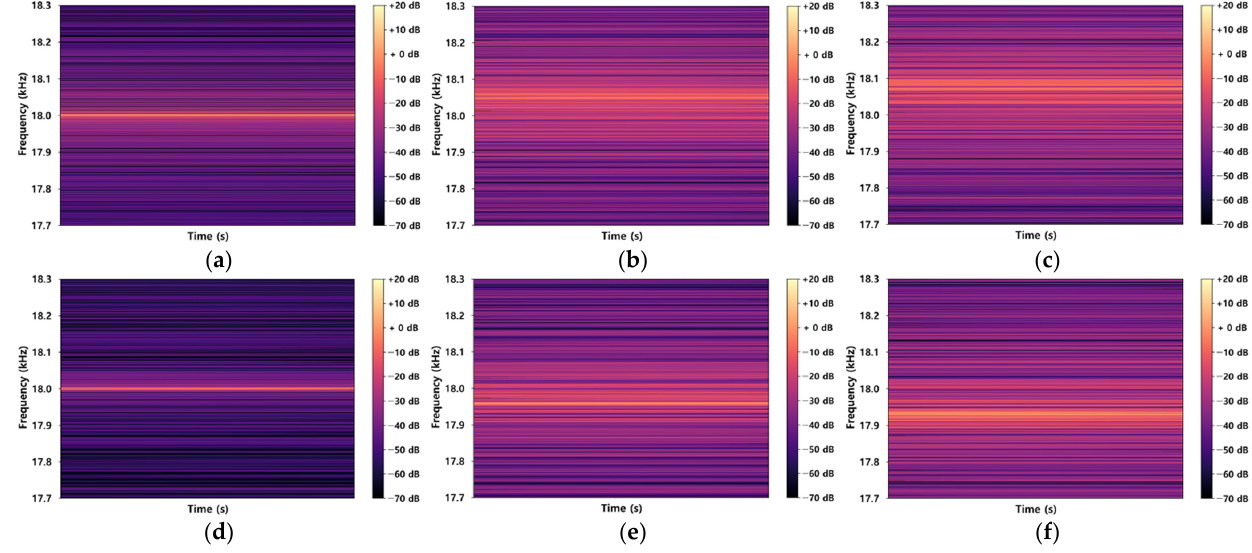
Figure 6. Spectrogram results from the indoor experiment: ( a ) Stationary (3 m), ( b ) Moving Forward (Slow), ( c ) Moving Forward (Fast), ( d ) Stationary (12 m), ( e ) Moving Backward (Slow), and ( f ) Moving Backward (Fast).